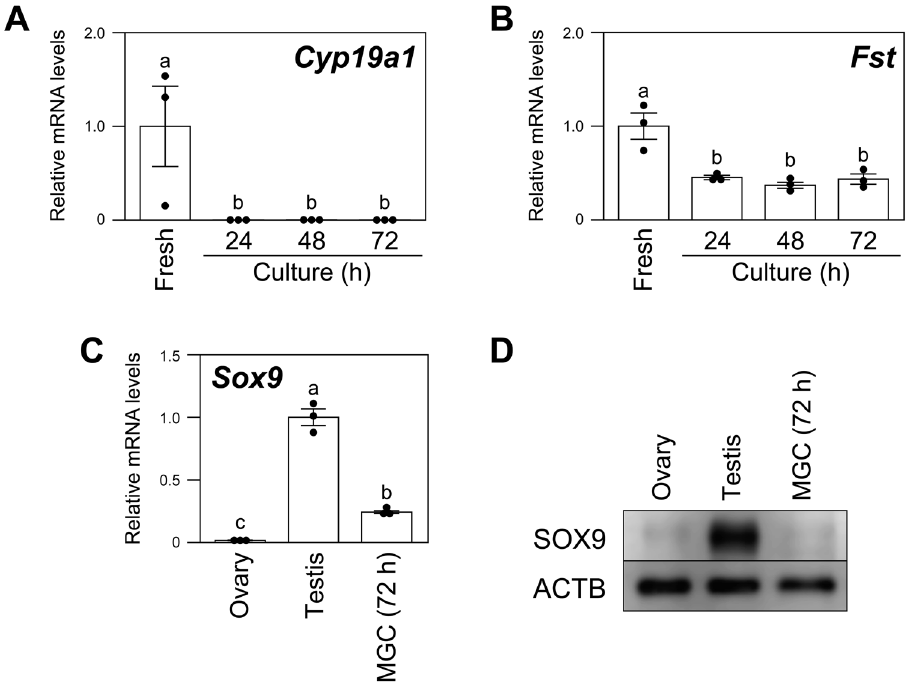
Figure 2. Effects of culture on the expression levels of transcriptional targets of FOXL2 in MGCs. Freshly isolated MGCs (Fresh) and MGCs cultured for 24, 48, and 72 h were examined for the expression kinetics of ( A ) Cyp19a1 , ( B ) Fst , and ( C ) Sox9 mRNAs by qPCR (n = 3). ( D ) The expression of SOX9 protein was examined by western blotting. Different letters (a, b, and c) denote significant differences ( p <